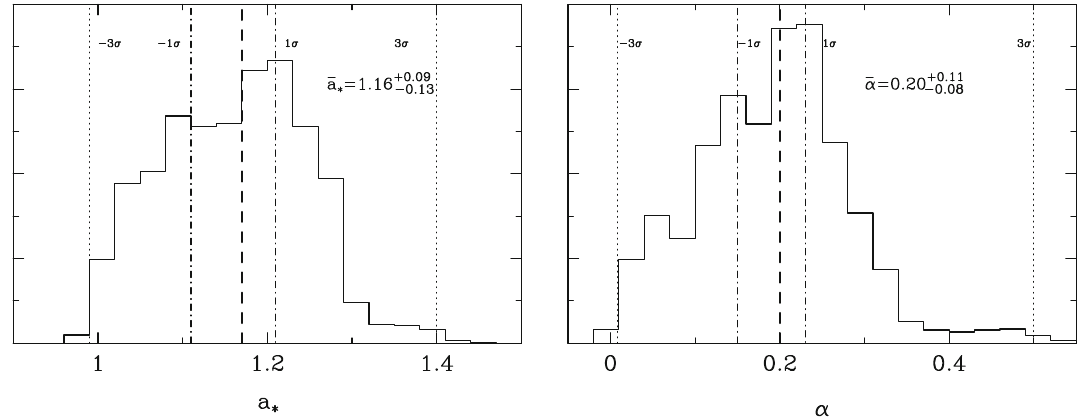
Fig. 7 Histograms of the spin parameter a ∗ (left panel) and of the deformation parameter α (right panel) for Ark 120 from our MCMC analysis. The thick-dashed vertical lines mark the mean value of the